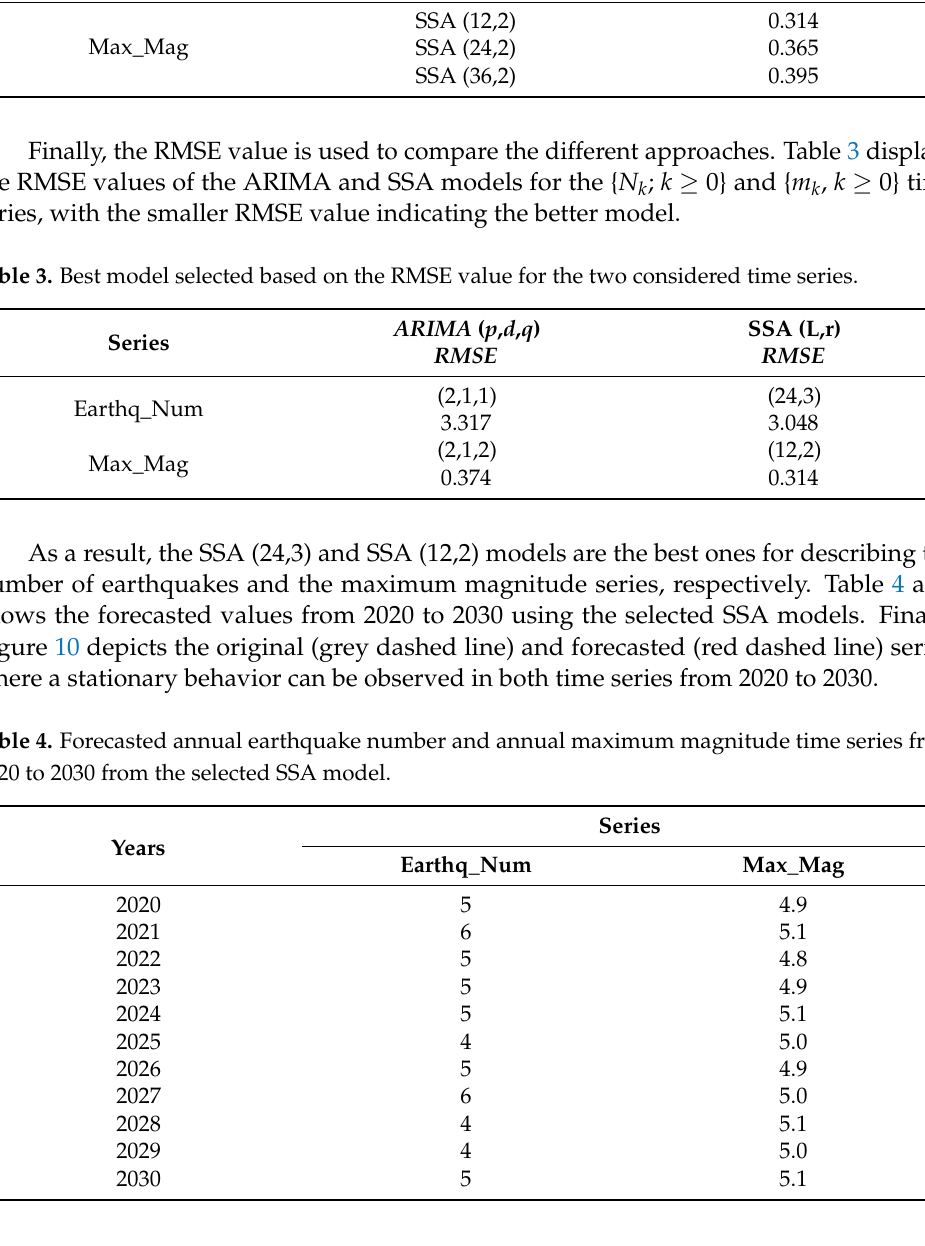
Table 2. The SSA chosen model based on the RMSE of the analyzed time series. Series Model RMSE Earthq_Num